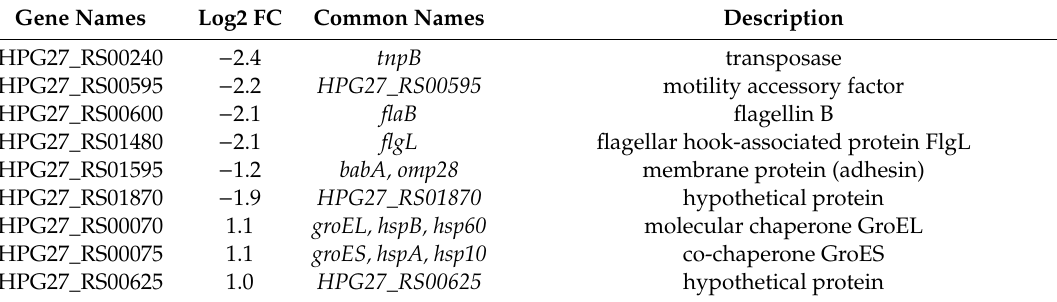
Table 1. List of up- and down-regulated genes.